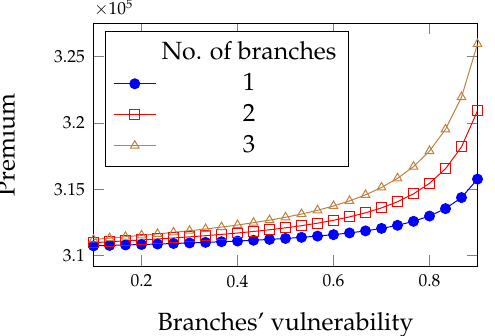
Figure 13. Overall security expense of the headquarters for the limited liability with deductibles case.